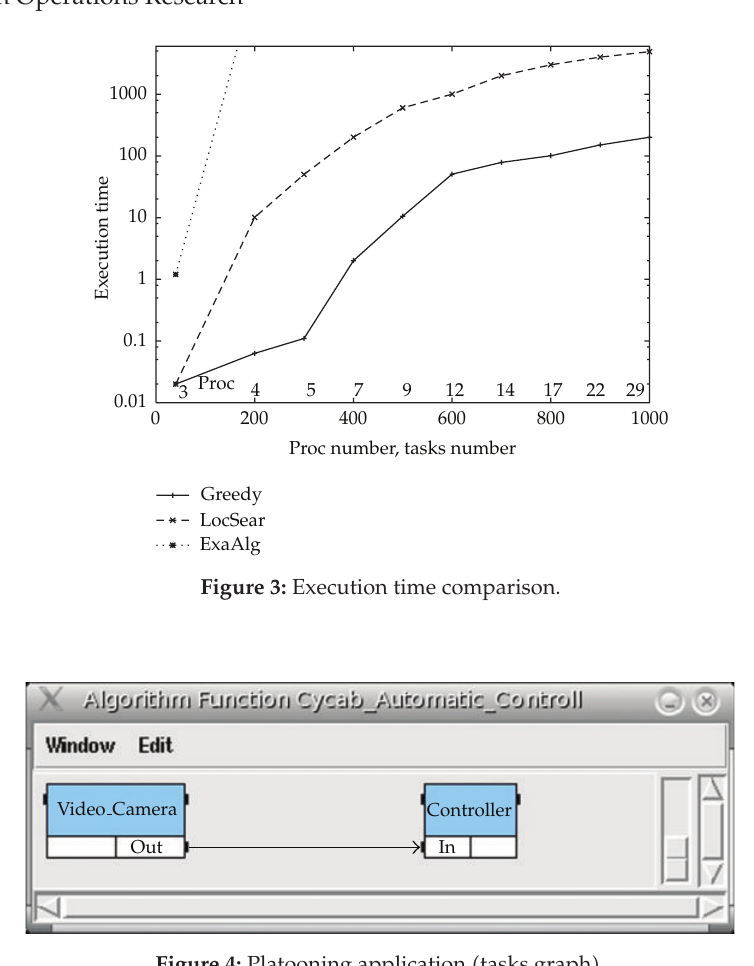
Figure 4: Platooning application (cid:3) tasks graph (cid:4)